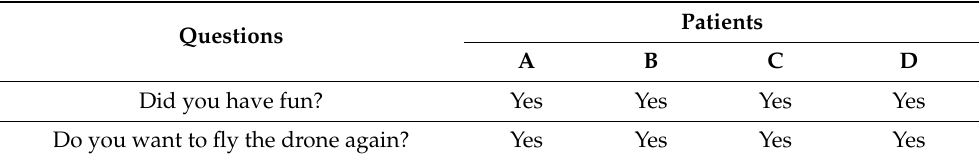
Table 8. Questionnaire results in the preliminary outdoor